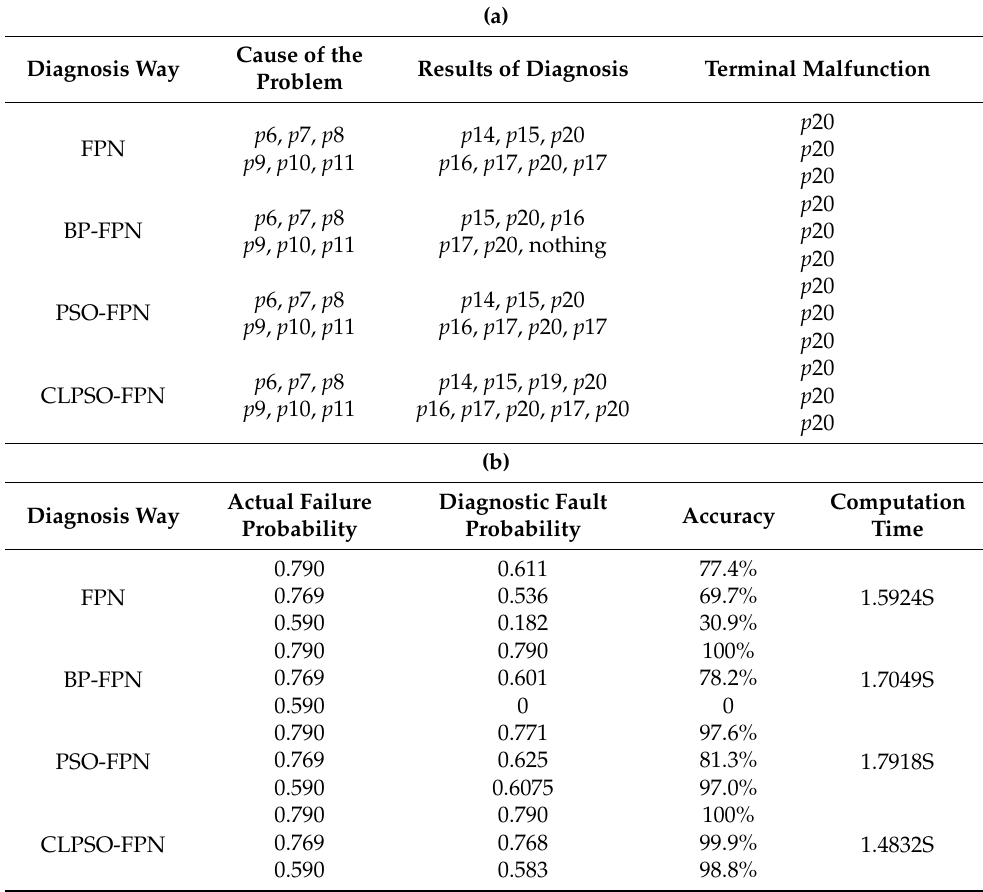
Table 5. The table of fault-diagnosis results. ( a ) The table of fault causes and diagnosis results; ( b ) the table of failure probability and